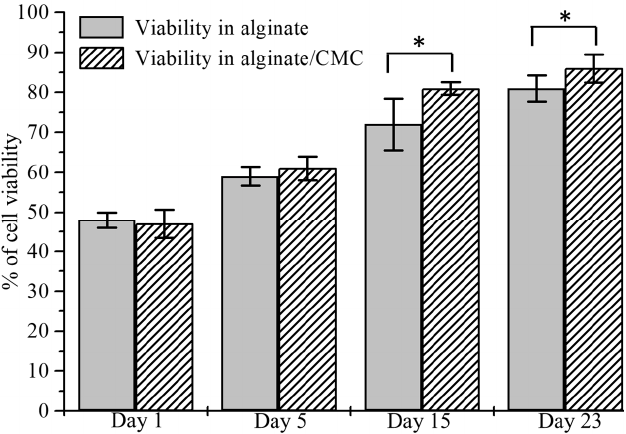
Figure 21. Comparison of cell viability into alginate and Alg-CMC at the different time.